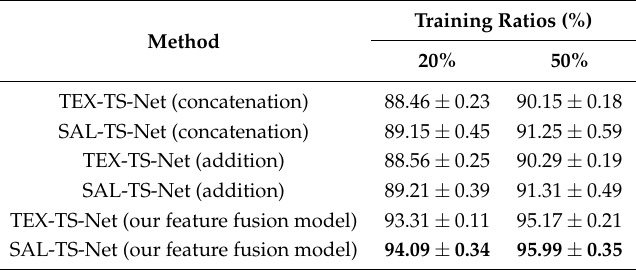
Table 3. Overall accuracies and standard deviations (%) of different feature fusion methods on the AID dataset.